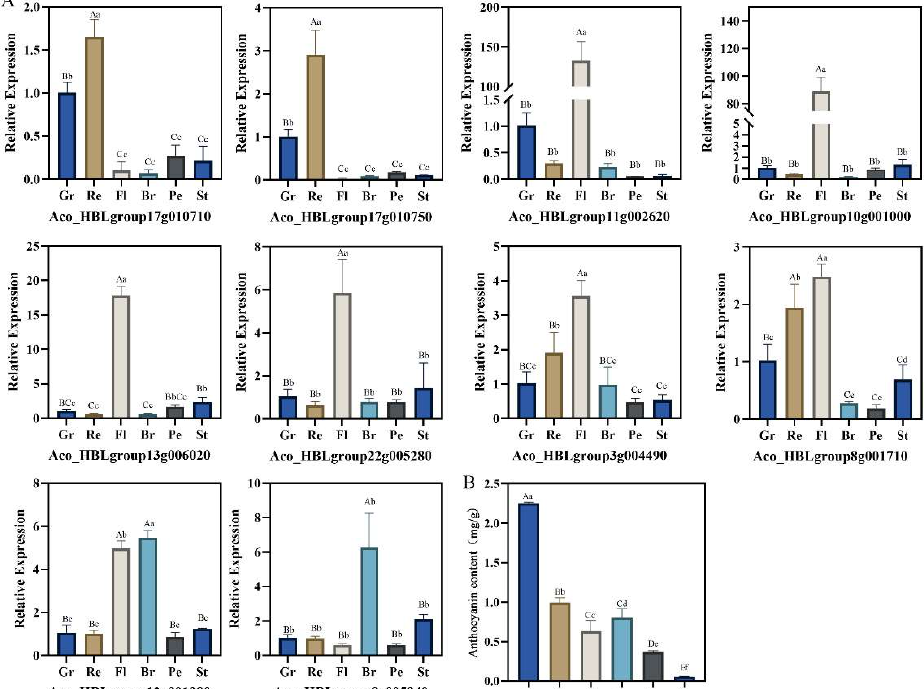
Figure 8. ( A ) The expression analysis of 10 anthocyanin biosynthesis-related candidate AbR2R3-MYBs in different tissues of A. comosus var. bracteatus . ( B ) Anthocyanin content in different tissues of A. comosus var. bracteatus . Gr, central green part of the chimeric leaf; Re, marginal red part of the chimeric leaf; Fl, flower; Br, bract; Pe, peel; St, stem bark. Different uppercase and lowercase letters indicate significant differences between different samples at the 0.01 and 0.05 levels, respectively.